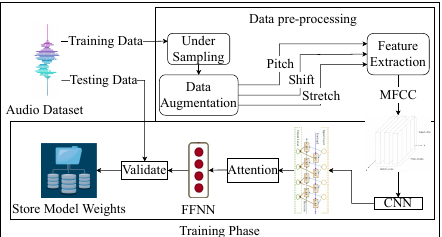
Figure 4. The training phase of the proposed